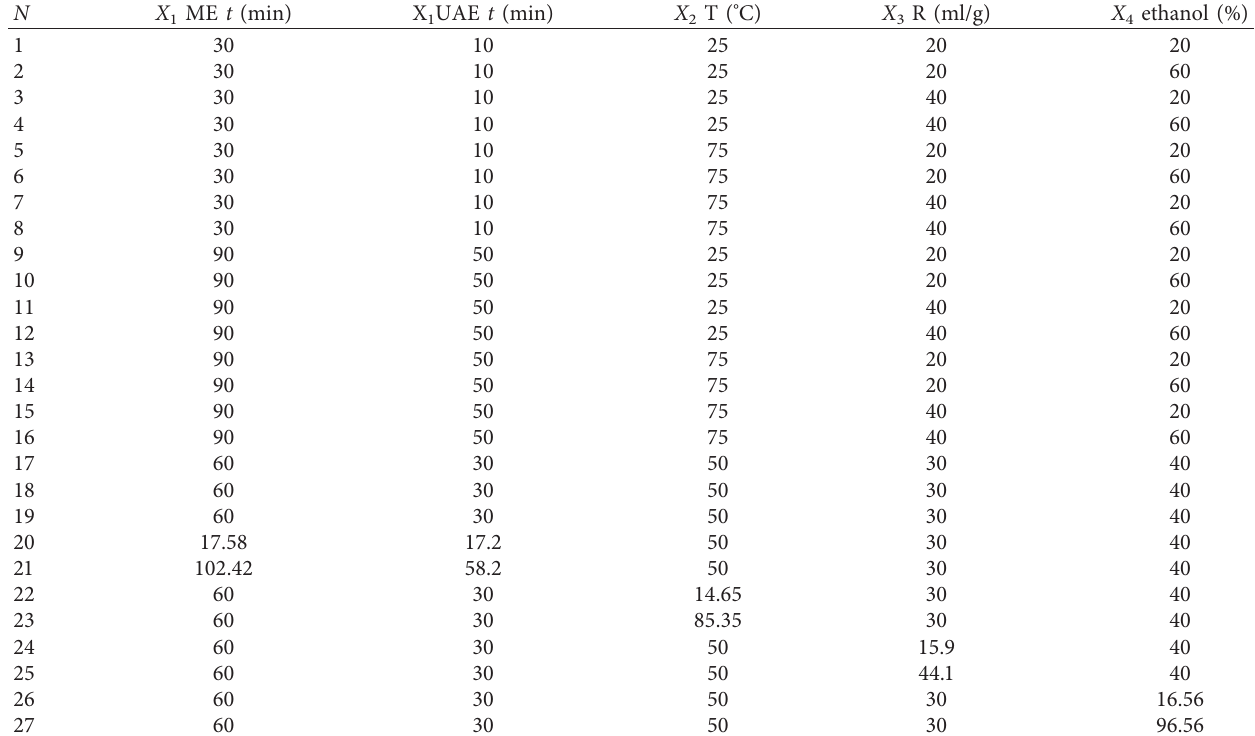
Table 1: The operating conditions according to an experiment plan.